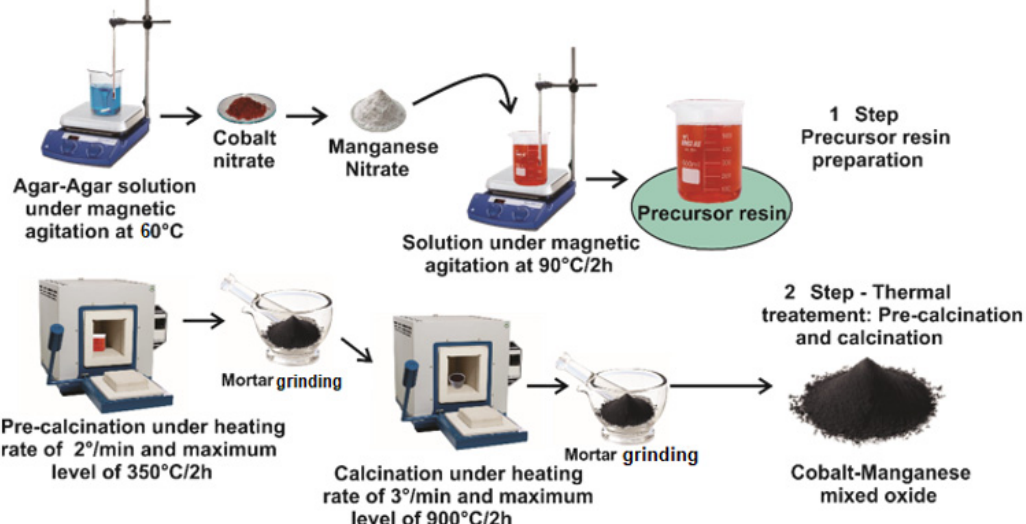
Figure 1. Procedure for the synthesis of samples Mn X Co 3-X O 4 (0 ≤ X ≤ 1).